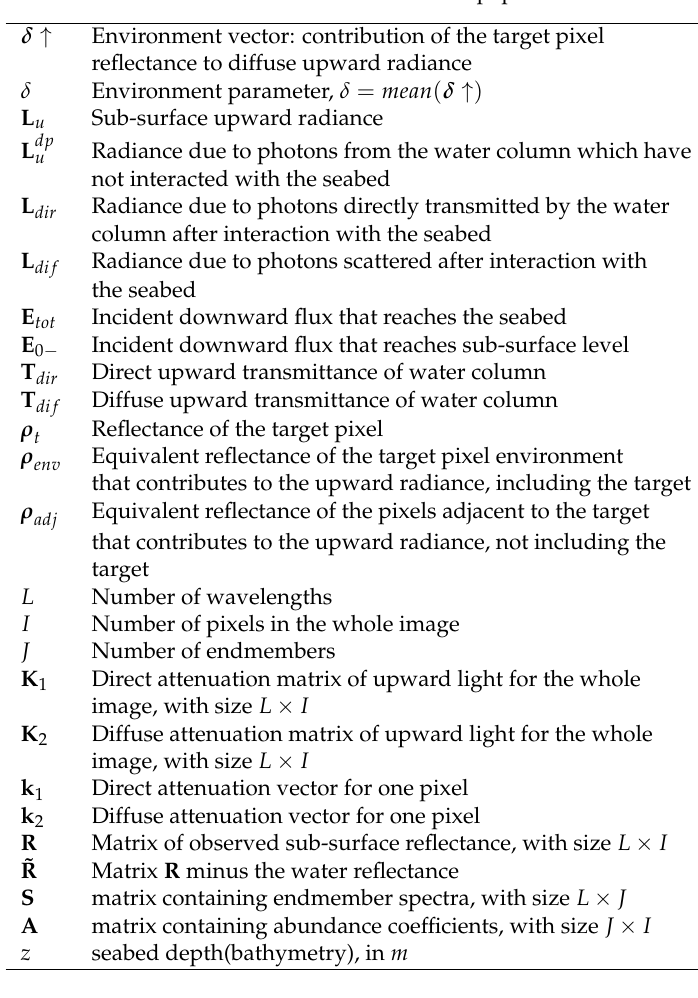
Table 1. Notations used in the